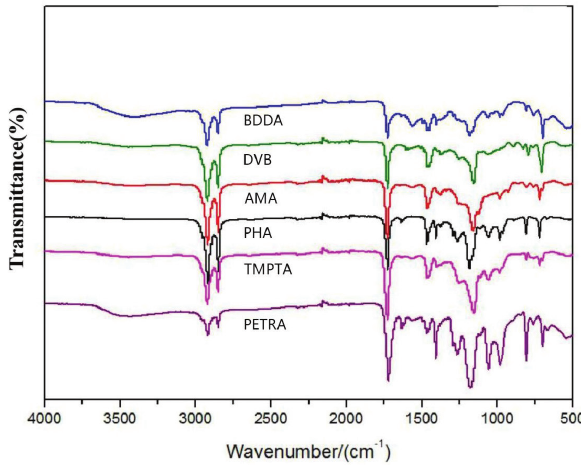
Figure 2: FTIR spectra of the microspheres with various cross-linking